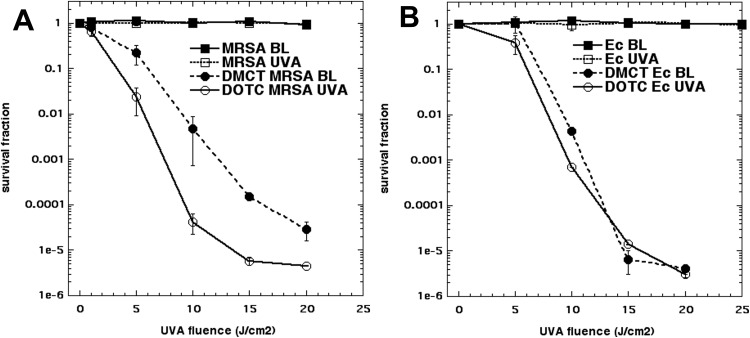
Light-dose dependent aPDI.Bacterial cells (E. coli UTI89 or MRSA) were incubated for 30 min in PBS with 10 μM tetracycline (DMCT or DOTC) and exposed to increasing fluences (J/cm2) of the appropriate light (UVA or BL) or to light alone controls. (A) MRSA; (B) E. coli.